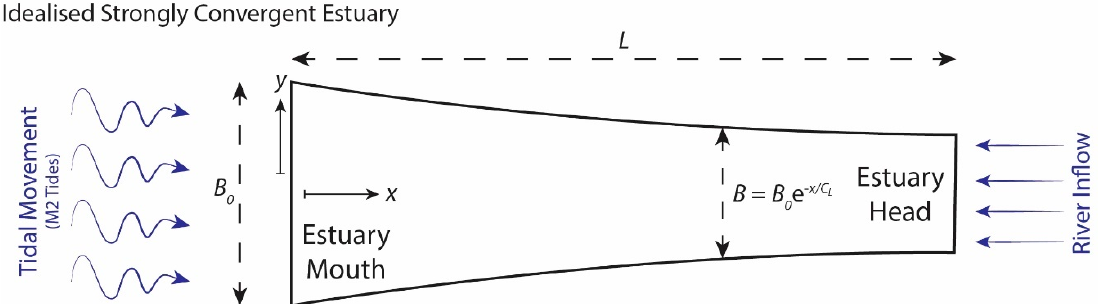
Figure 1. Plan view of different estuarine geometries investigated in this study including prismatic (top panel), converging with C L = 160 km (middle panel), and converging with C L = 80 km (bottom panel). All panels depict co-ordinate system, driving forces, and boundary conditions.